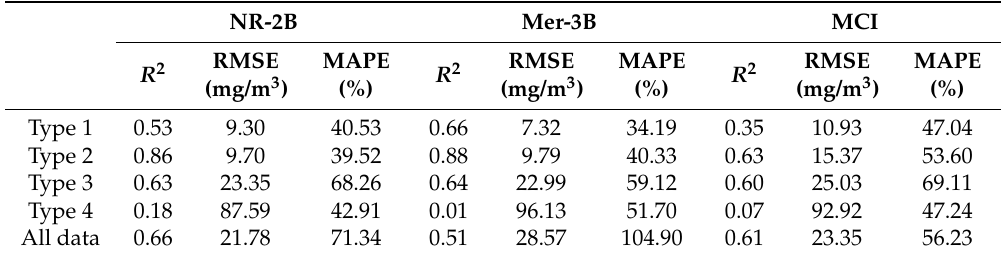
Table 2. Uncertainty statistics of the four OWTs and all data for the derived Chl a from the three algorithms (NR-2B, Mer-3B, and MCI) using the field-measured data. NR-2B